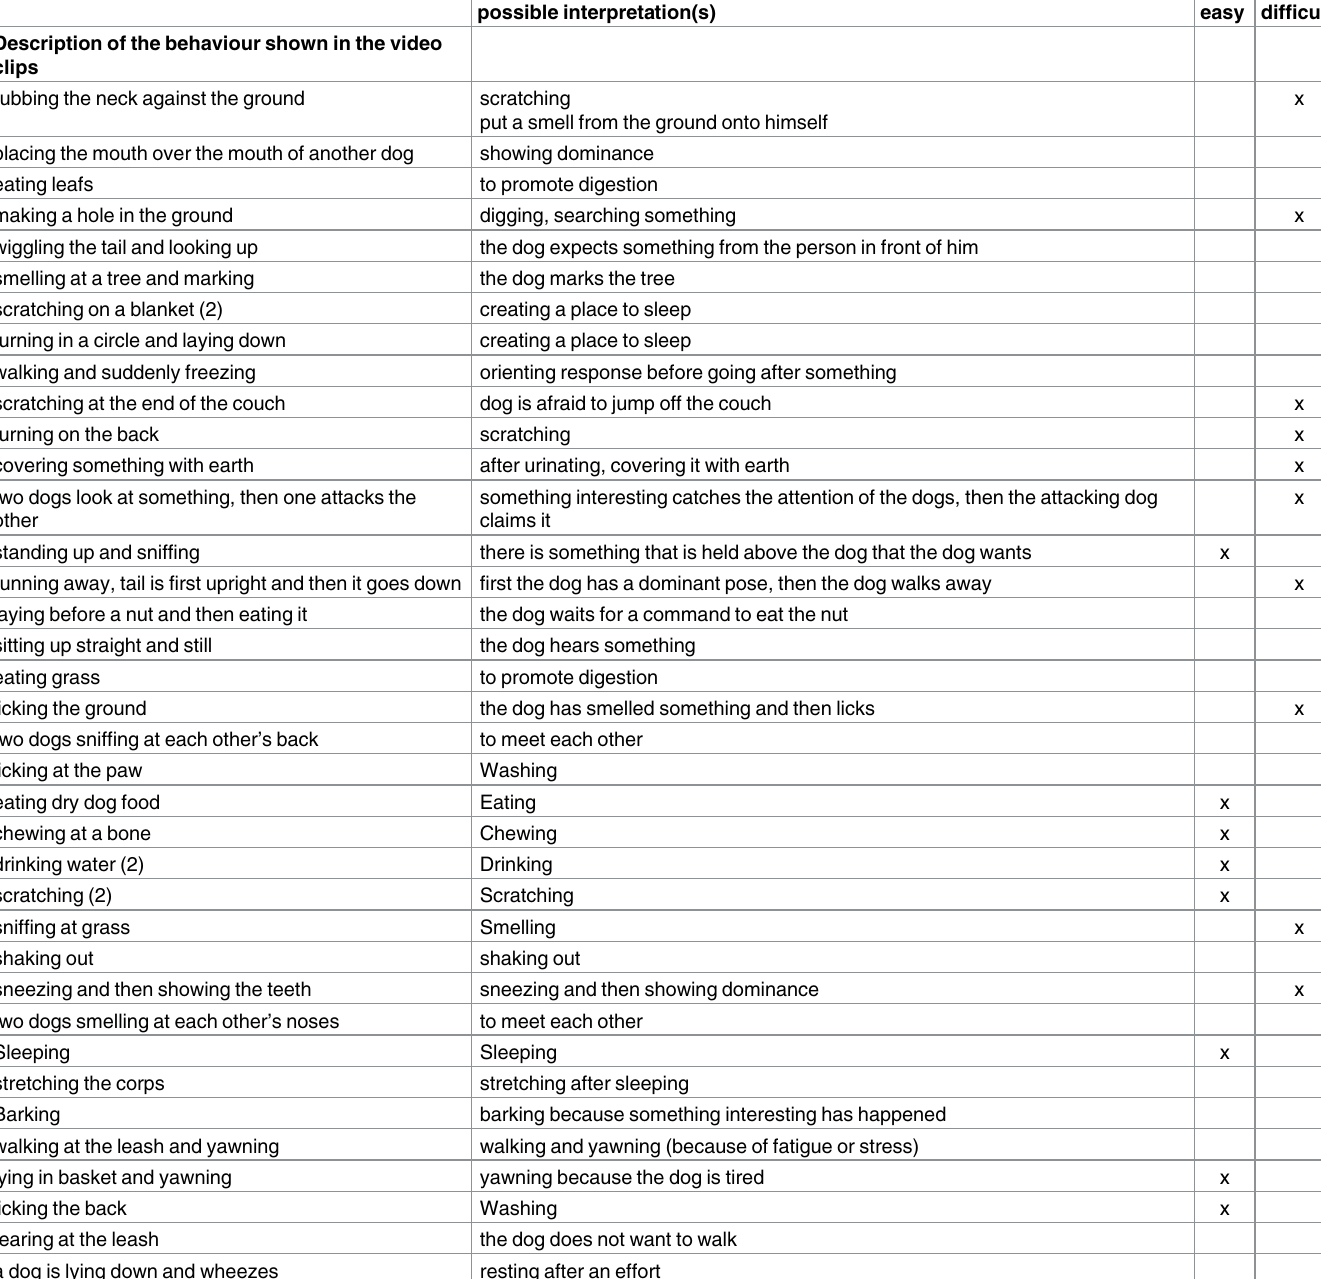
Table 1. Description of the 40 video clips showing dog behaviour and the corresponding possible interpretation(s). The twenty video clips that receivedthe most extreme scores on the difficulty ratings after scanningare marked with a cross in the column ‘easy’ (10 clips with the lowest scores) or ‘diffi- cult’ (10 clips with the highest scores). In the fMRI analyses, brain activationduringthe observation of these ten difficult video clips is comparedwith brain acti- vation during the observationof these ten easy video clips. Some video clips showedthe same behaviour. For example,there are two video clips that showed a dog drinkingwater. When this is the case the numberof video clips showingthis behaviouris